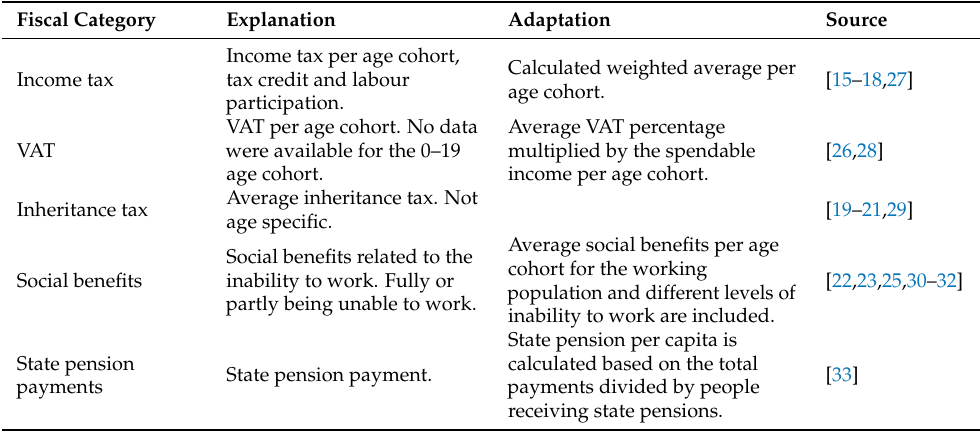
Table 1. Overview of fiscal categories identified through literature search and expert